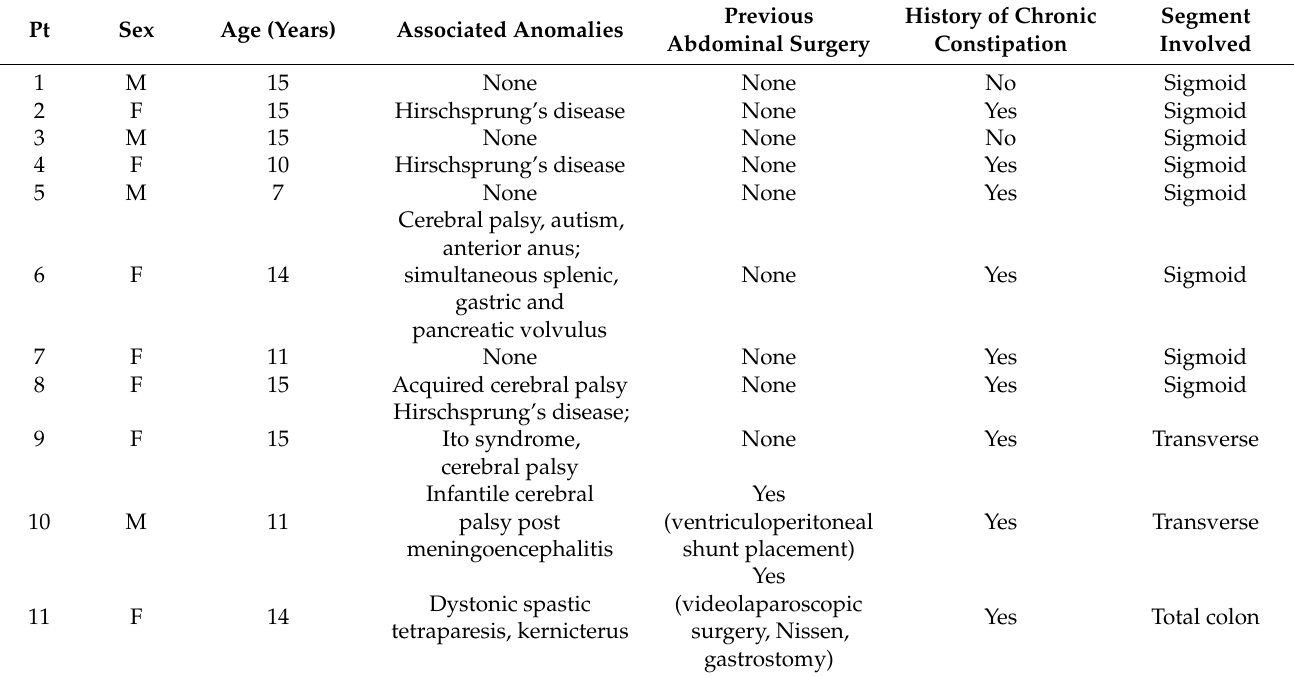
Table 1. Patients’